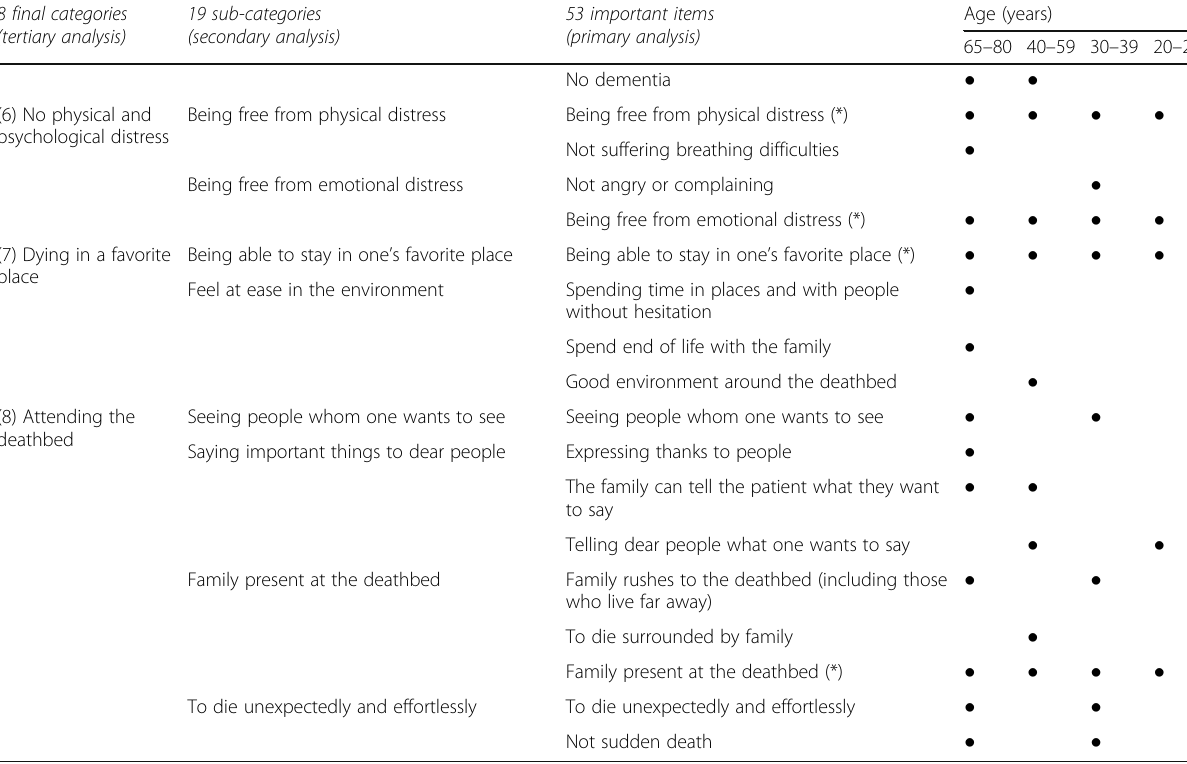
Table 3 Eight important categories of “ Desirable Death ” and nine important items common to all generations (Continued) 8 final categories 19 sub-categories (tertiary analysis) (secondary